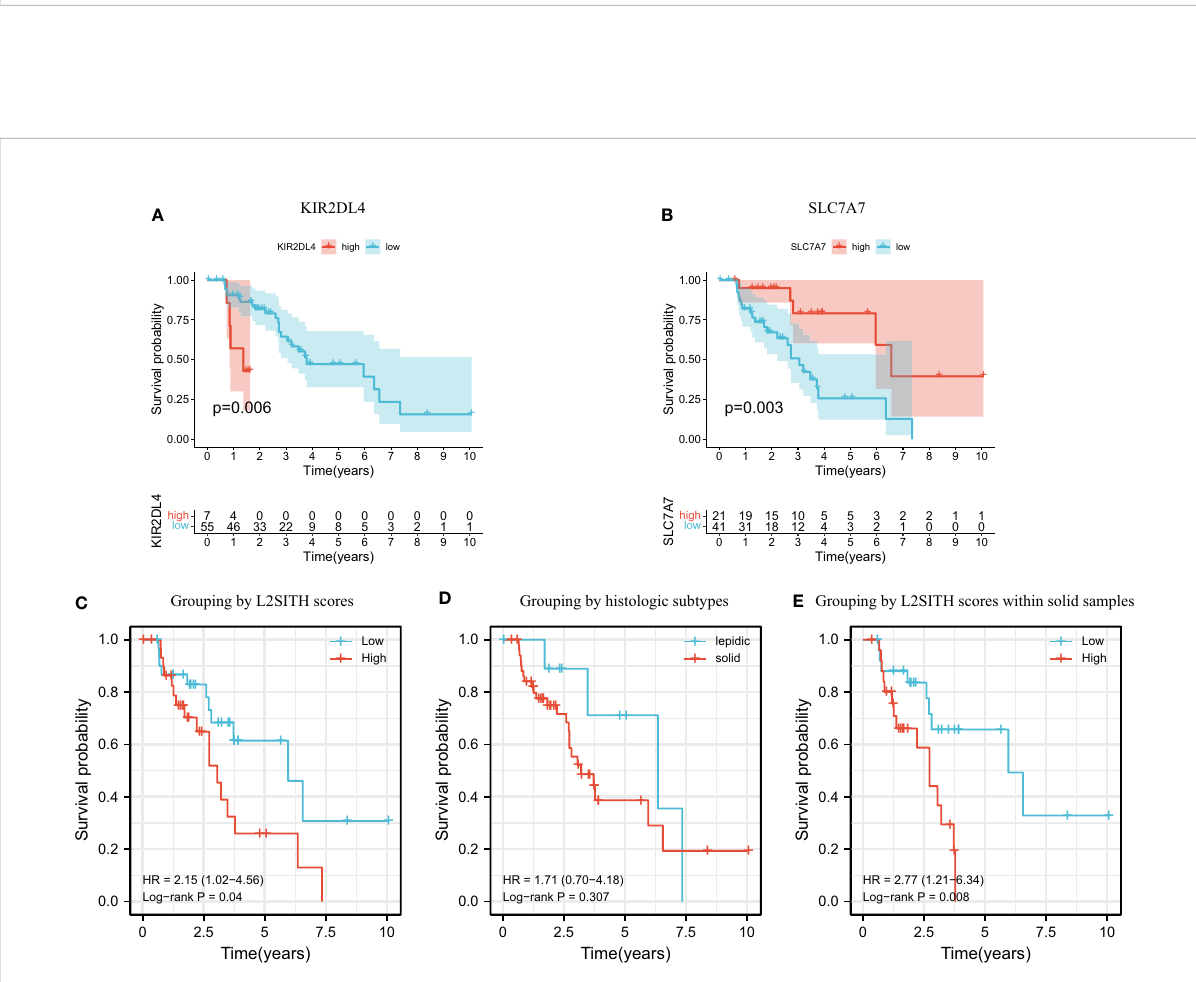
FIGURE 5 Survival analysis of two key genes, L2SITH heterogeneity score, and histologic phenotype. Panels (A, B) showed the K-M survival curves of patients grouped by KIR2DL4 and SLC7A7 gene, respectively. (C) K-M survival curve of patients grouped by L2SITH heterogeneity score. (D) K-M survival curve of patients grouped by lepidic and solid subtypes. (E) K-M survival curve of the solid group patients divided by L2SITH heterogeneity